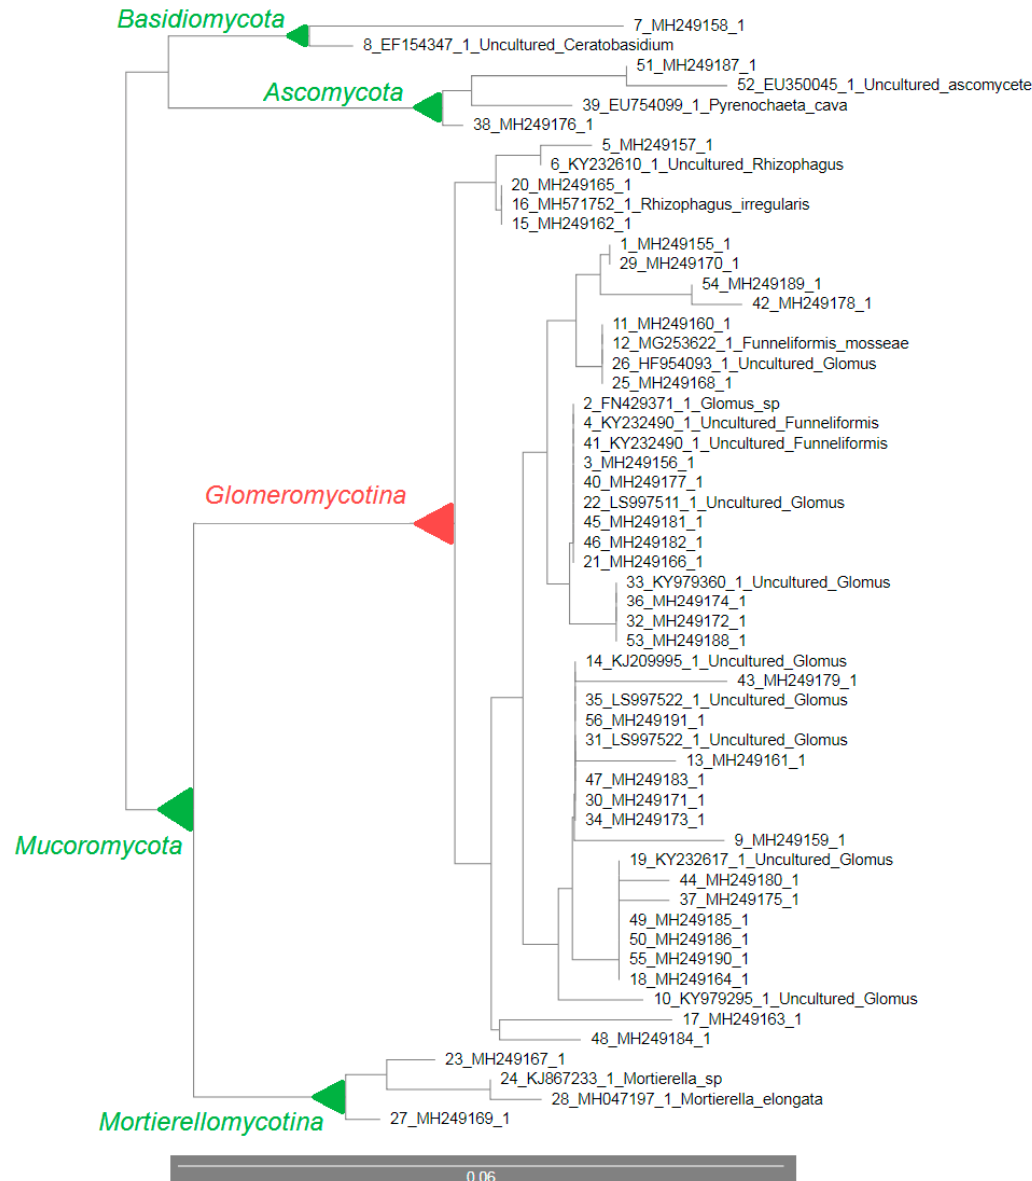
Figure 4. The phylogram constructed using Unweighted Neighbor-Joining method generated from the 18S rDNA sequences obtained from the rhizosphere of Arundo donax in the soil without sewage sludge (SS) with the sequences of fungi with the highest similarity (our sequences are indicated only with GenBank ID).